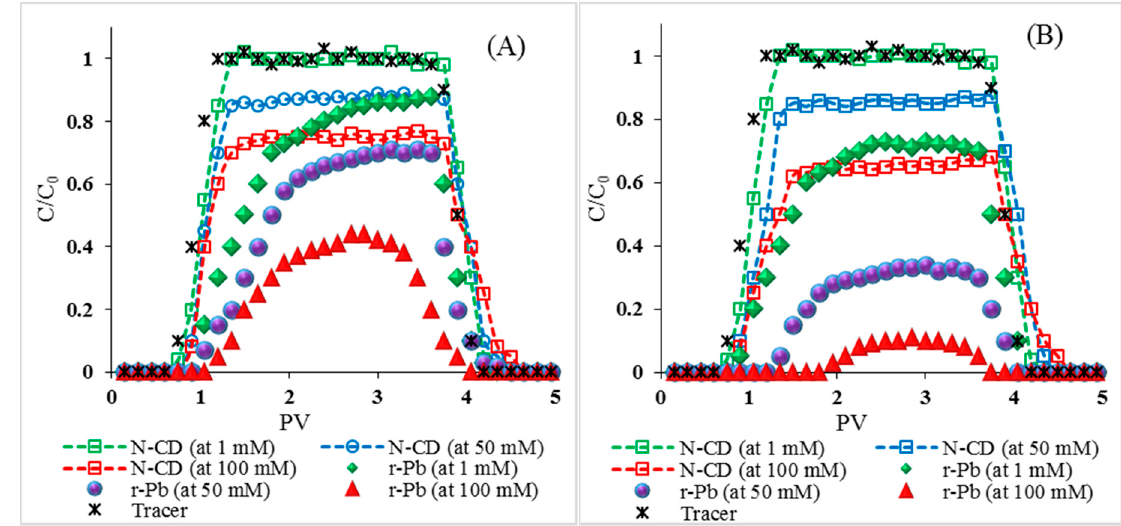
Figure 5. Breakthrough curves (BTCs) of N-CD and released Pb (r-Pb) at different ionic strength: NaCl ( A ), CaCl 2 ( B ). All experiments were performed in C 0 (N-CD/CD): 50 mg·L − 1 , C 0 (Pb): 10 mg·L − 1 , pH 6, background solution containing: 1 mM NaCl/CaCl 2 , NaHCO 3 (1 mM), 1 rpm (3.075 mL·min − 1 ) flow rate.